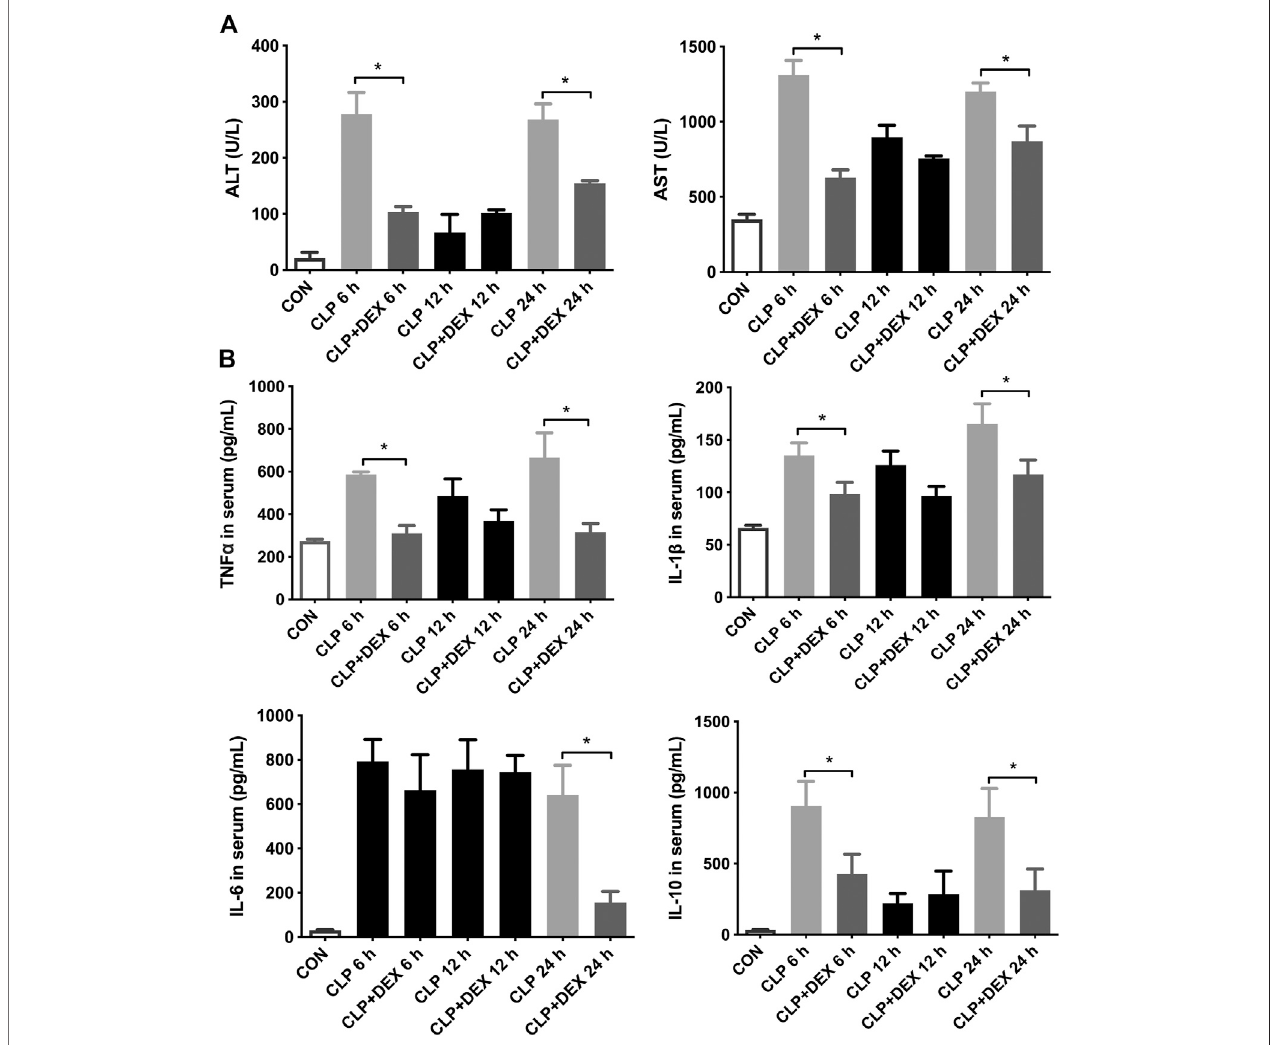
FIGURE2| DEXreducedliverdysfunctionandin fl ammationinCLP-inducedliverinjury. (A) DEXimprovedliverdysfunctioninCLP-inducedliverinjury:Thelevelsof serum ALT and serum AST at 6, 12, and 24 h in mice. (B) The content of in fl ammatory cytokines in serum, including TNF- α , IL-1 β , IL-6, and IL-10, as determined using ELISA. * p <